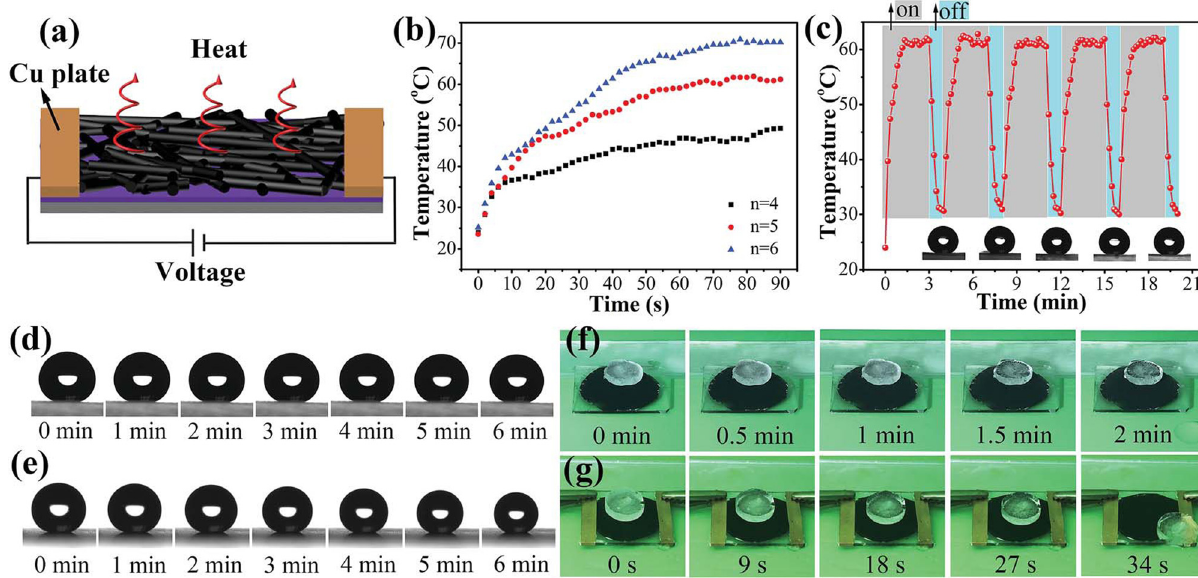
Figure 18: ( a ) Schematic of heat production of the composite fi lm under applied voltage. ( b and c ) Temperature variation of the ODA/ ( carboxylated - MWCNTs/aminated - MWCNTs ) n fi lm ( n = 4, 5, 6 ) with ( b ) time and ( c ) repeated heating/cooling cycles. The evolution of droplets ( d and f ) on unheated SHPC fi lm and ( e and g ) heated SHPC fi lm at 30 V [ 99 ] . Reproduced with permission from ref. [ 99 ] ; © 2018 The Royal Society of